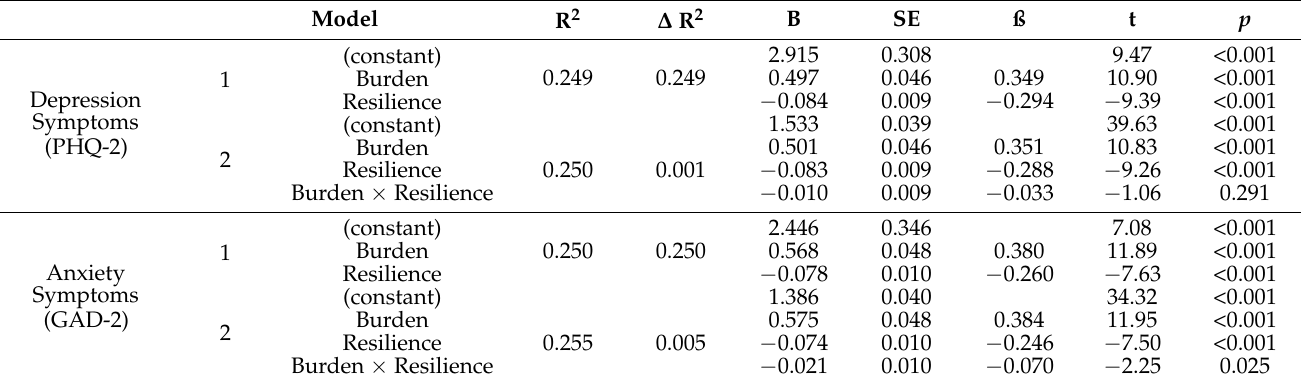
Table 3. Interaction effects of resilience and subjective stress burden on mental health.